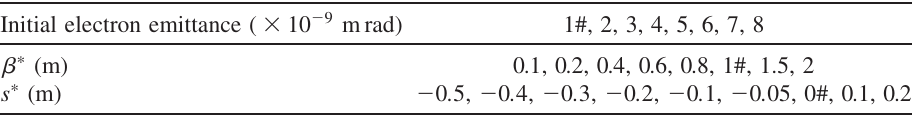
TABLE III. Table of example parameters used in the optics optimization (design values are marked with #).